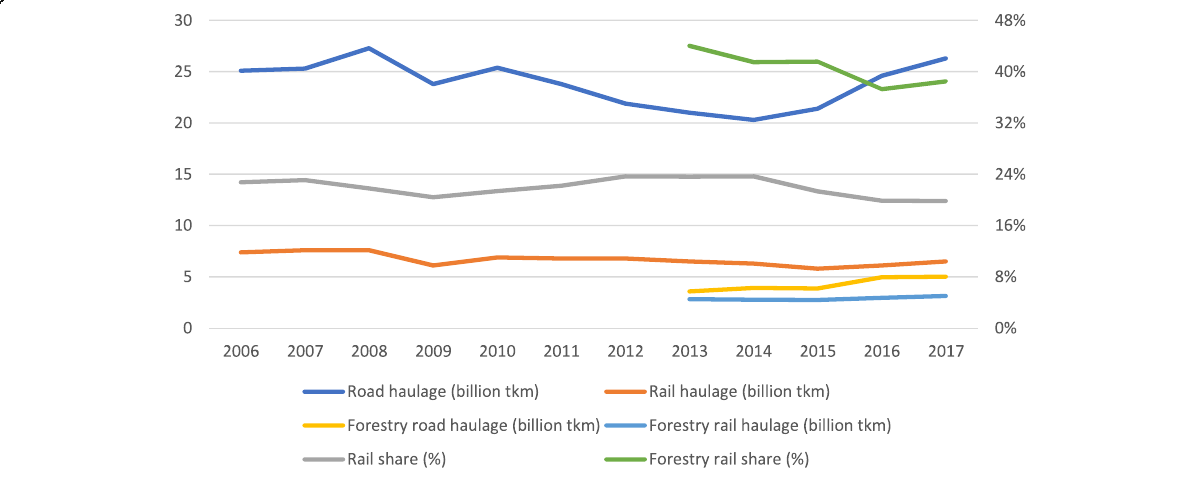
Fig. 4 Development of haulage by road and rail in 2006 – 2017 in Finland, with forestry as the largest commodity shown separately (please